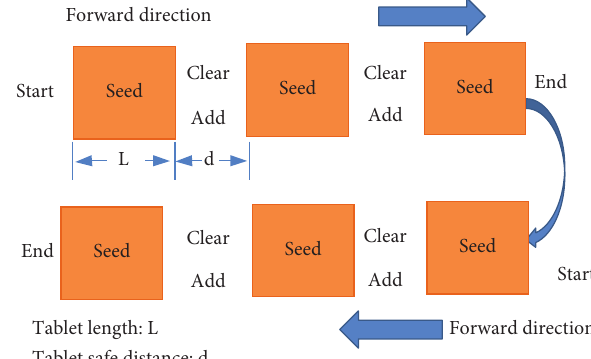
Figure 1: Diagram of tablet